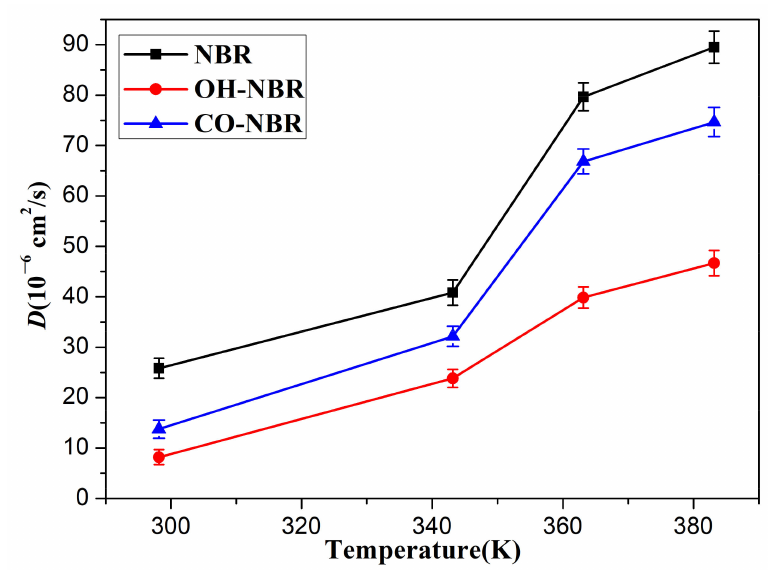
Figure 7. The diffusion coefficients of the oxygen molecules in the unaged and aged NBR models at different